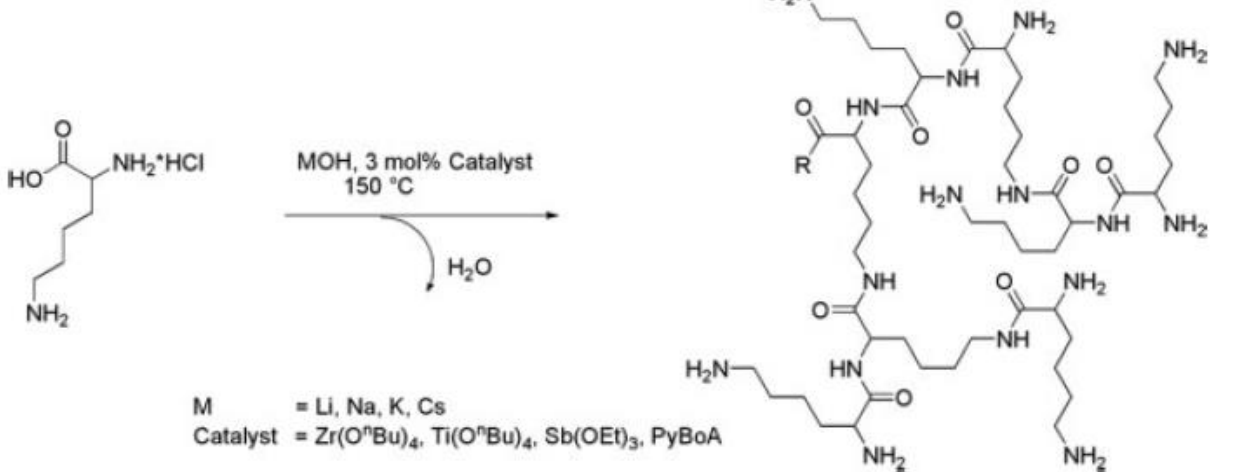
Figure 8. Thermal synthesis of hyperbranched p( L -Lys) in the melt in a one-pot synthesis from L -lysine hydrochloride, reproduced with permission from Scholl et al. [121].